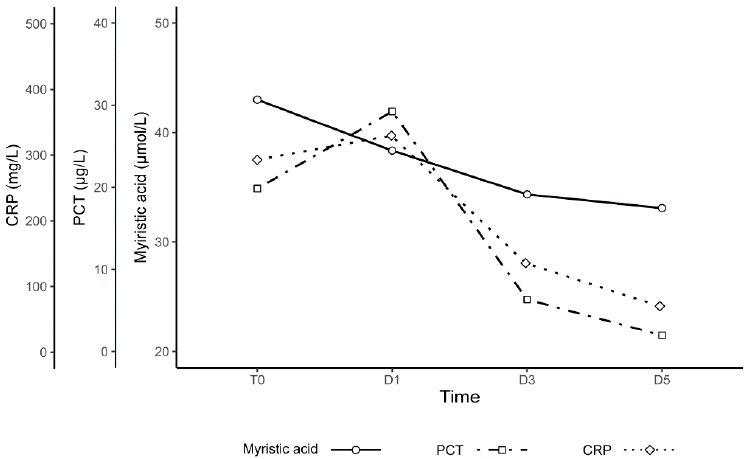
Figure 5. Illustrative timeline of PCT, CRP, and myristic acid levels in the Sepsis Group at T0–D5 samplings. The values are represented as median, the error bars have been left out for lucidity reasons. Comparing the Sepsis Group patients at T0 with the Healthy Control Group, the ROC analysis identified a myristic acid concentration of 24.3 µmol/L (AUC 0.961) as the cut-off value for prediction of sepsis with 87.9% sensitivity and 100% specificity (see Figure 6a). By comparison of the septic patients with bacteraemia at T0 with the Healthy Control Group, the ROC analysis determined a myristic acid concentration of 37.2 µmol (AUC 0.992) as the cut-off value for prediction of septic bacteraemia with 91.7% sensitivity and 100% specificity (see Figure 6b). The cut-off value of 42.1 µmol/L for myristic acid, derived from the ROC analysis (AUC 0.837), discriminated sepsis with bacteraemia from SIRS with 83.3% sensitivity and 83.9% specificity (see Figure 6c). To predict bacteraemia within the Sepsis Group at T0, the cut-off value of 43.7 µmol/L for myristic acid determined by the ROC analysis (AUC 0.756) showed 75% sensitivity and 71.4% specificity (see Figure 6d). ( a )